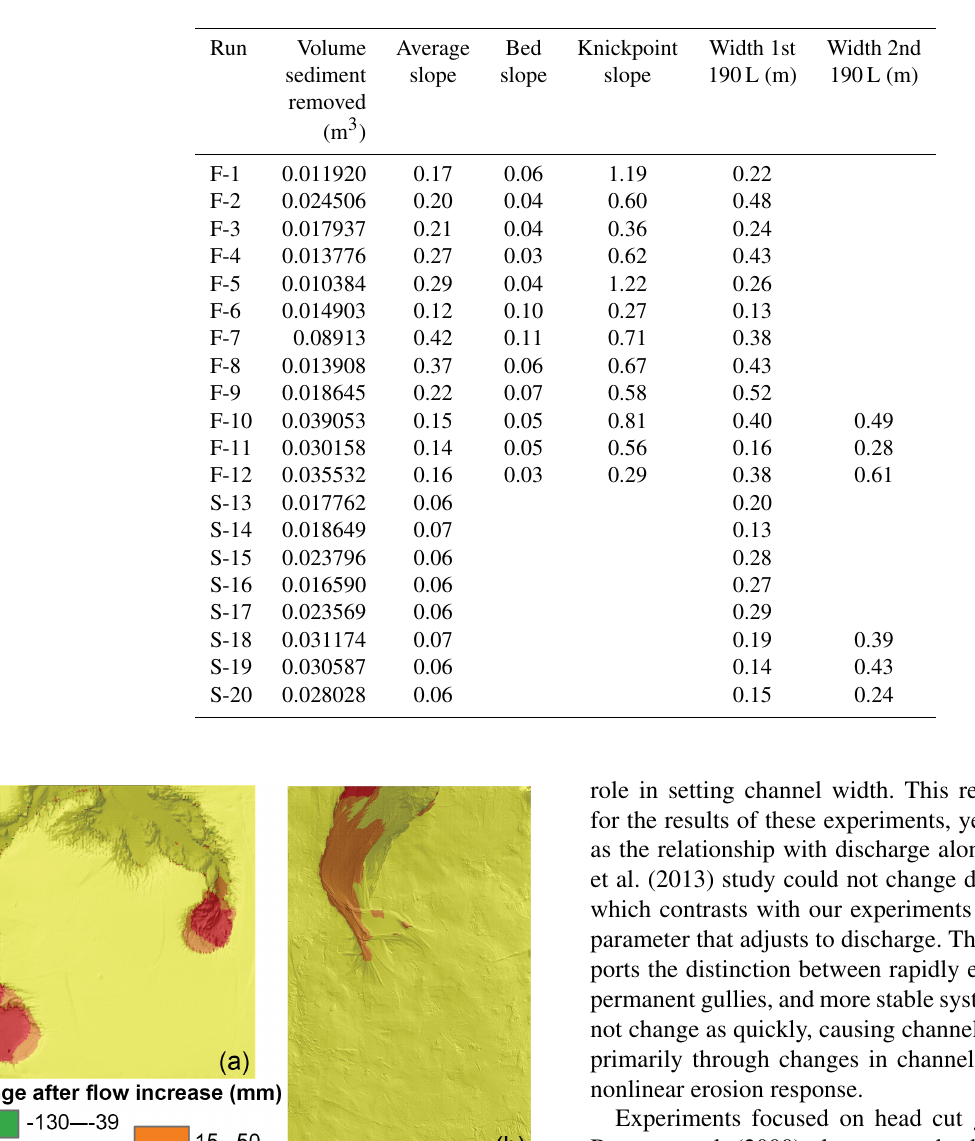
Table 2. Experimental results.